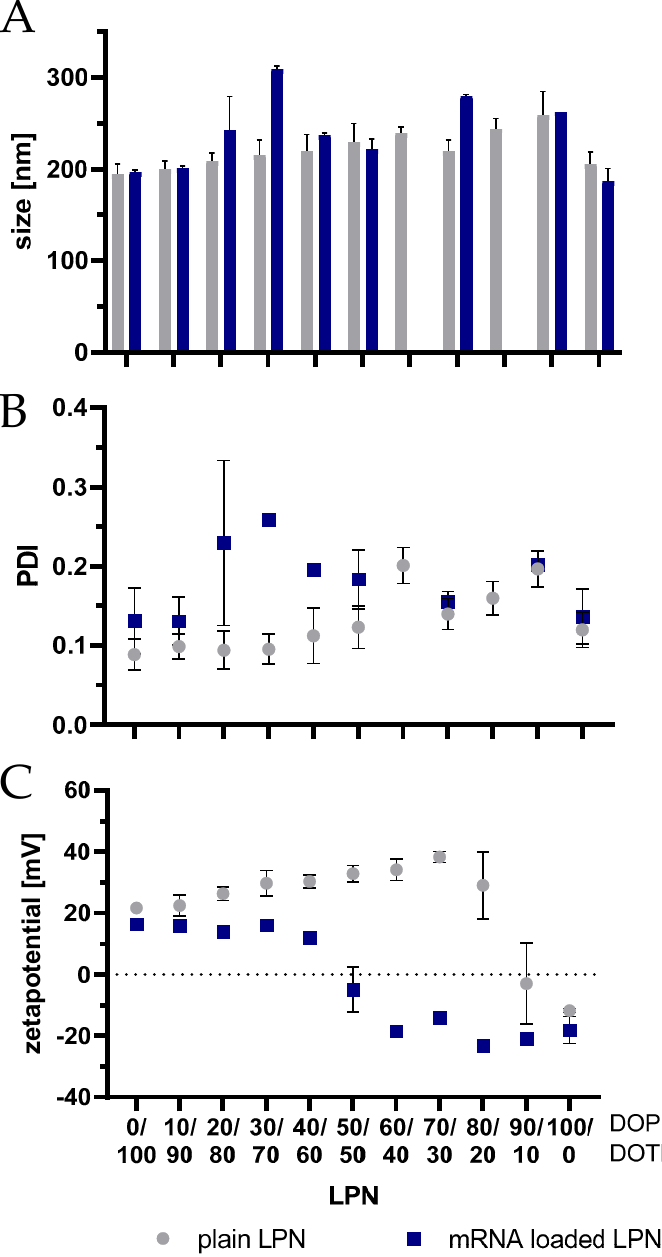
Figure 3. Physicochemical parameters of lipid-polymer nanoparticles (LPN) with and without complexed mRNA. ( A ) size in nm, ( B ) polydispersity index (PDI), ( C ) zetapotential in mV. Data is displayed as mean and standard deviation between batches (3–5 batches for plain, 1–2 batches for loaded LPNs). Plain LPNs have comparable sizes and PDI. The more DOPE the nanoparticles contain, the higher is the measured zetapotential of the plain LPN. Inversion of zetapotential after surface loading of mRNA onto LPNs with at least 50% DOPE in lipid